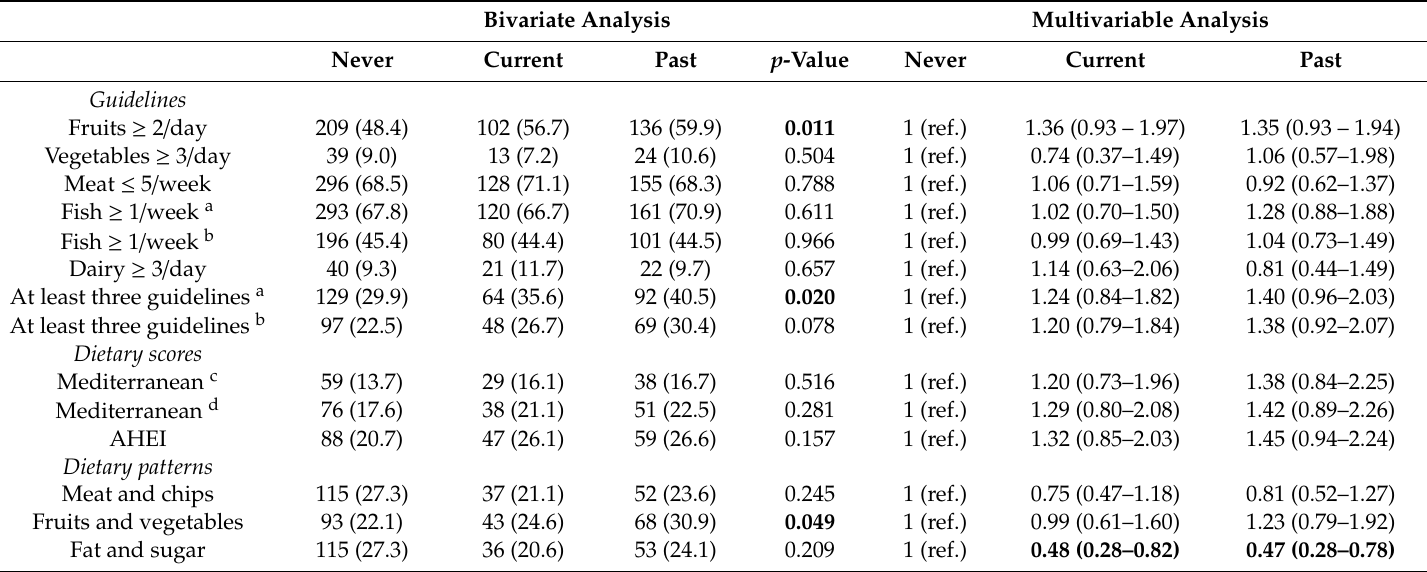
Table 3. Compliance with dietary recommendations and dietary scores according to menopausal hormone therapy. Bivariate Analysis Multivariable